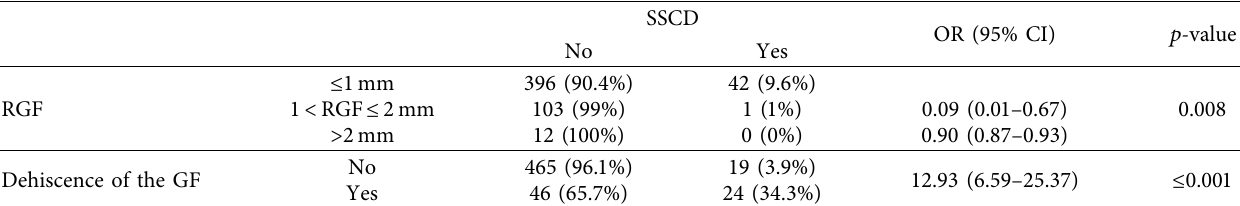
Table 4: Te relationship between the presence/absence of SSCD and the dehiscence/thickness of the RGF